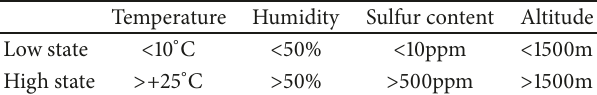
Table 4: The boundary between the high and low